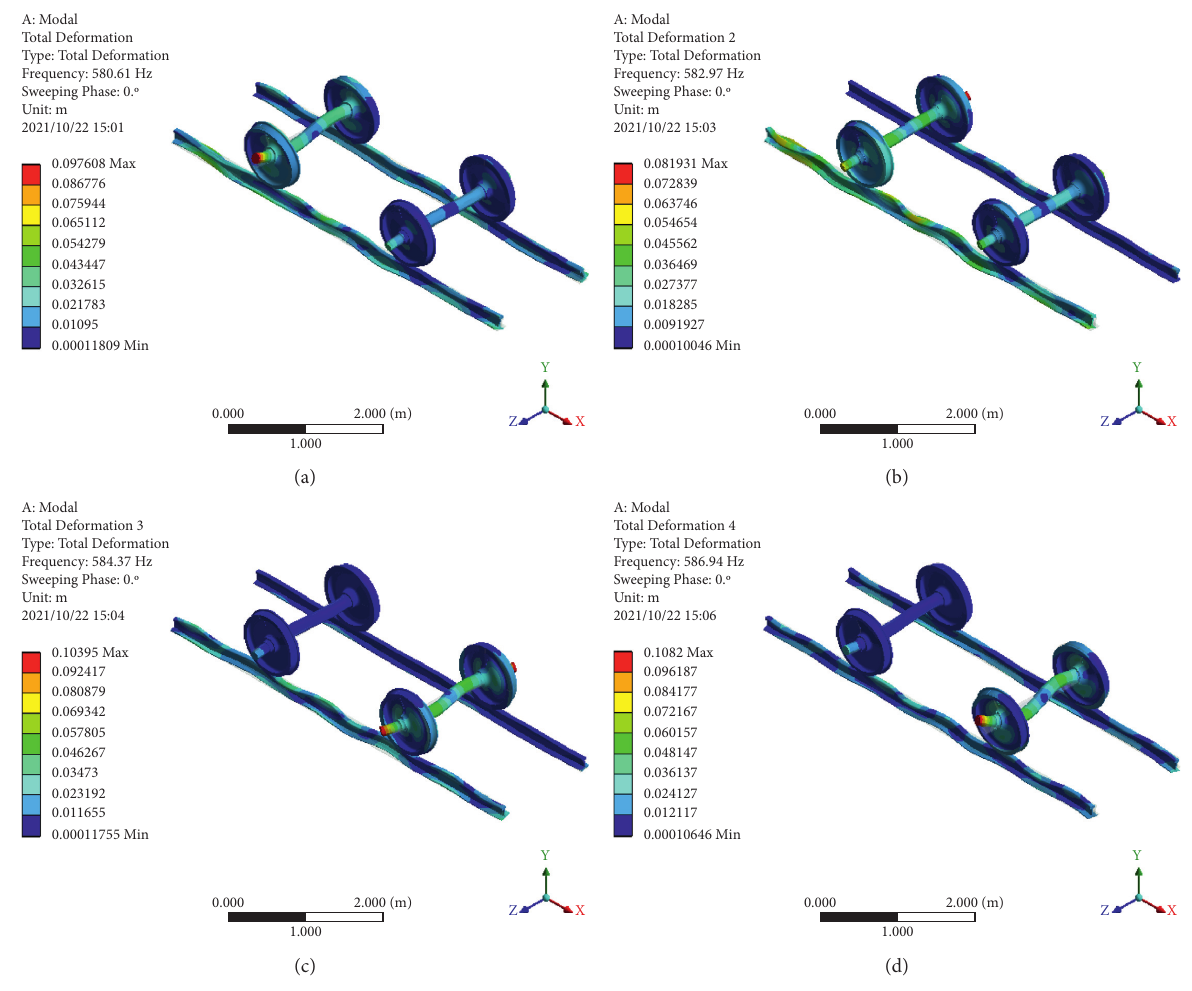
Figure 9: Vibration mode of wheel track coupling system with ω � 180rad/s. (a) Wheelset 3rd vertical bending and track 8th lateral bending. (b) Wheelset 3rd vertical bending and track 8th lateral bending. (c) Wheelset 3rd vertical bending and track 8th lateral bending and vertical bending. (d) Wheelset 3rd vertical bending and track 8th vertical